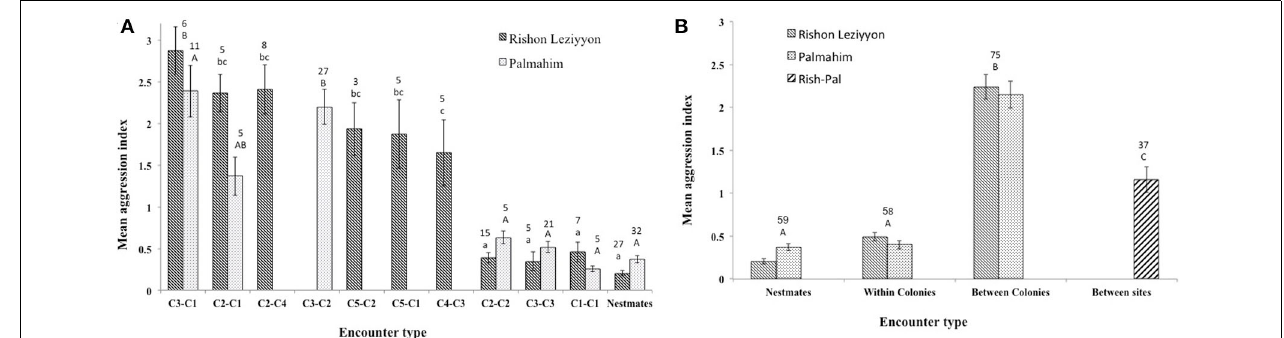
FIGURE 2 | Mean aggression ( ± standard error) between workers in the different encounter types from either Rishon Leziyyon (hatched bars) or Palmahim (dotted bars) sites. (A) Data of encounters between particular genetic colonies including (1) Nestmates; (2) workers from different nests belonging the same genetic colony (e.g., C2–C2); and (3) of nests belonging to different genetic colonies (e.g., C3-C2).